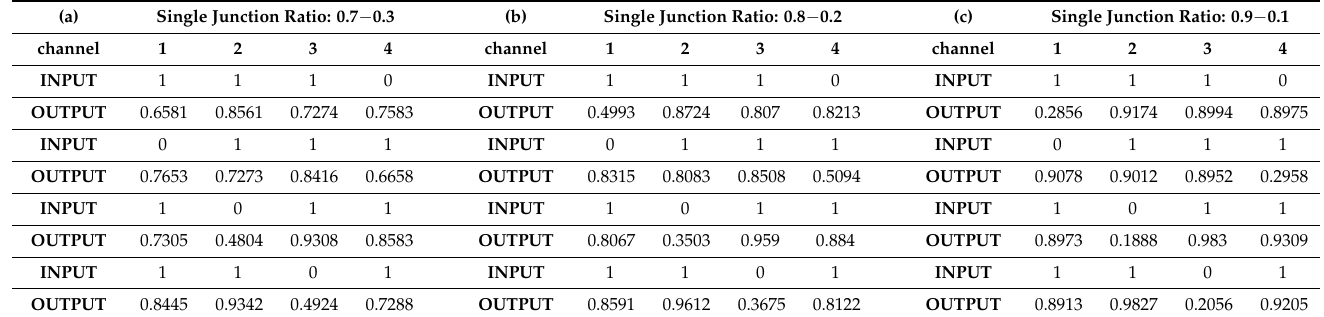
Table 4. Results of the simulation outputs of the mathematical model for 3-digit, 4-bit numbers and